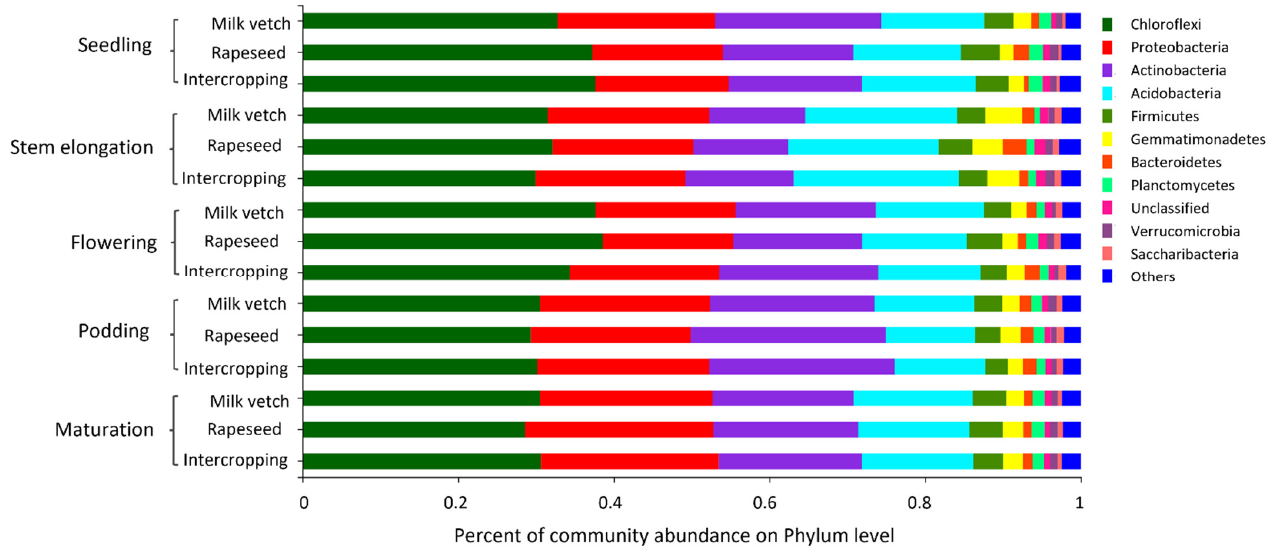
Figure 4. Percentage of soil microbial community abundance at phylum level.